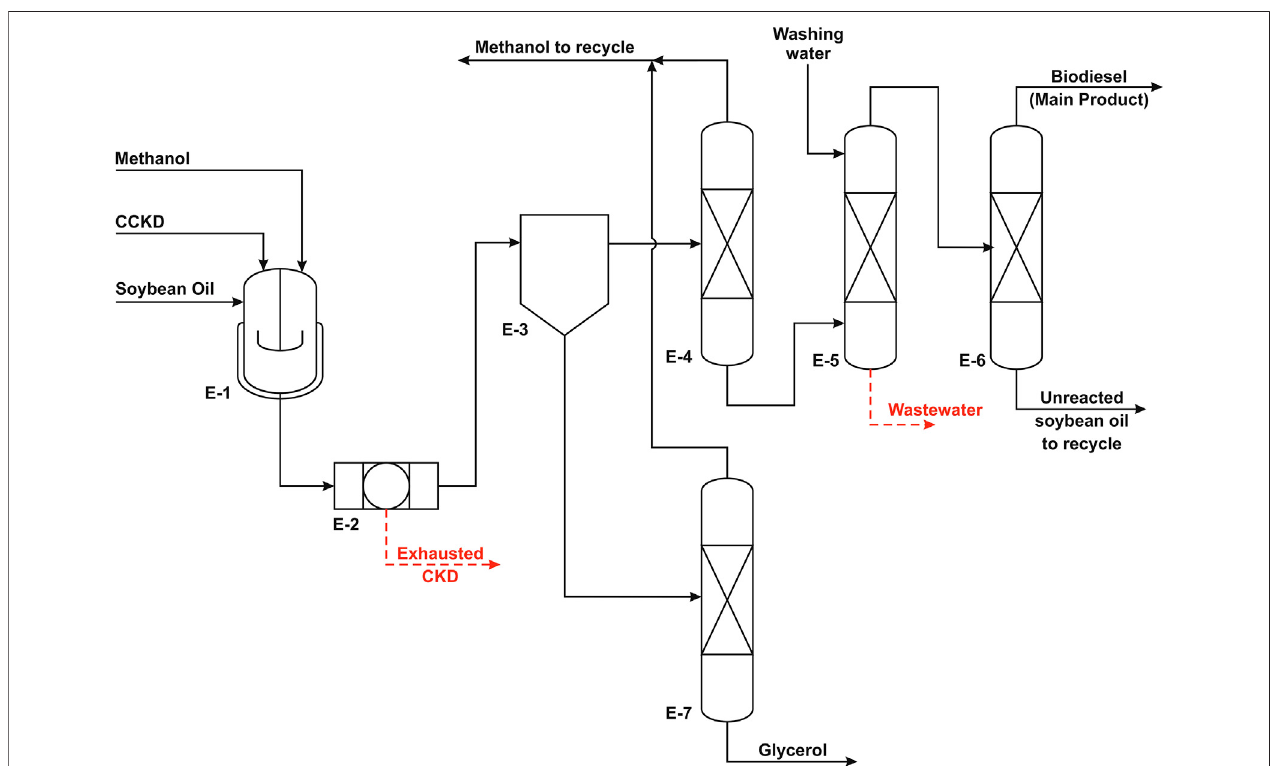
FIGURE 3 | Process fl ow diagram of the heterogeneous process (adapted from El-Sheltawy et al., 2016).